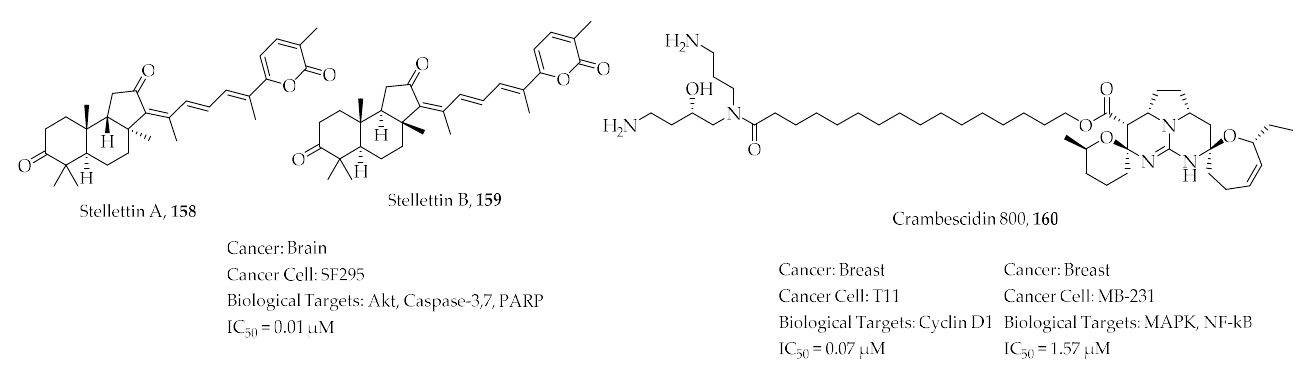
Figure 39. Structures of the isomalabaricane-type terpenoids Stellettin A and B and a pentacyclic guanidine alkaloid Crambescidin 800 with a summary of their biological activity towards selected cancer targets.